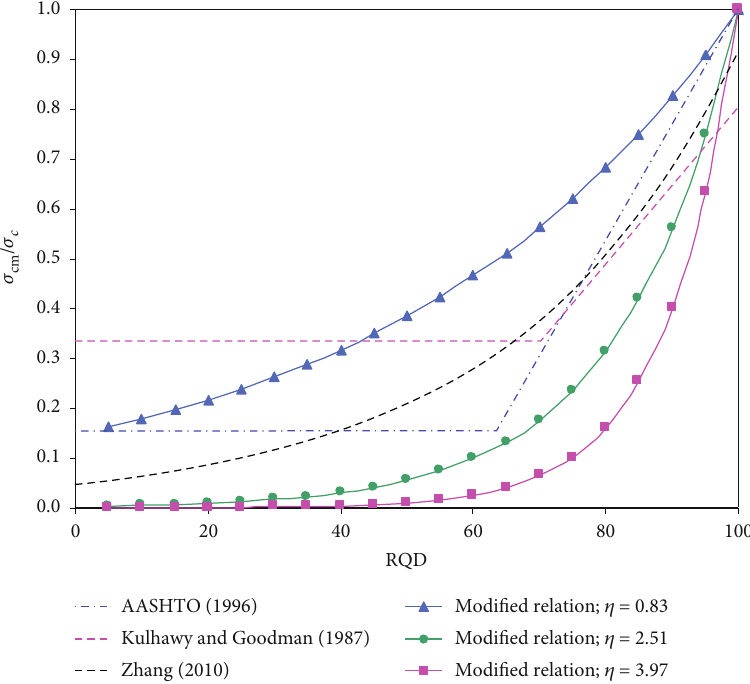
Figure 4: Comparison between the modi fi ed σ and Rao [68], respectively. Segment